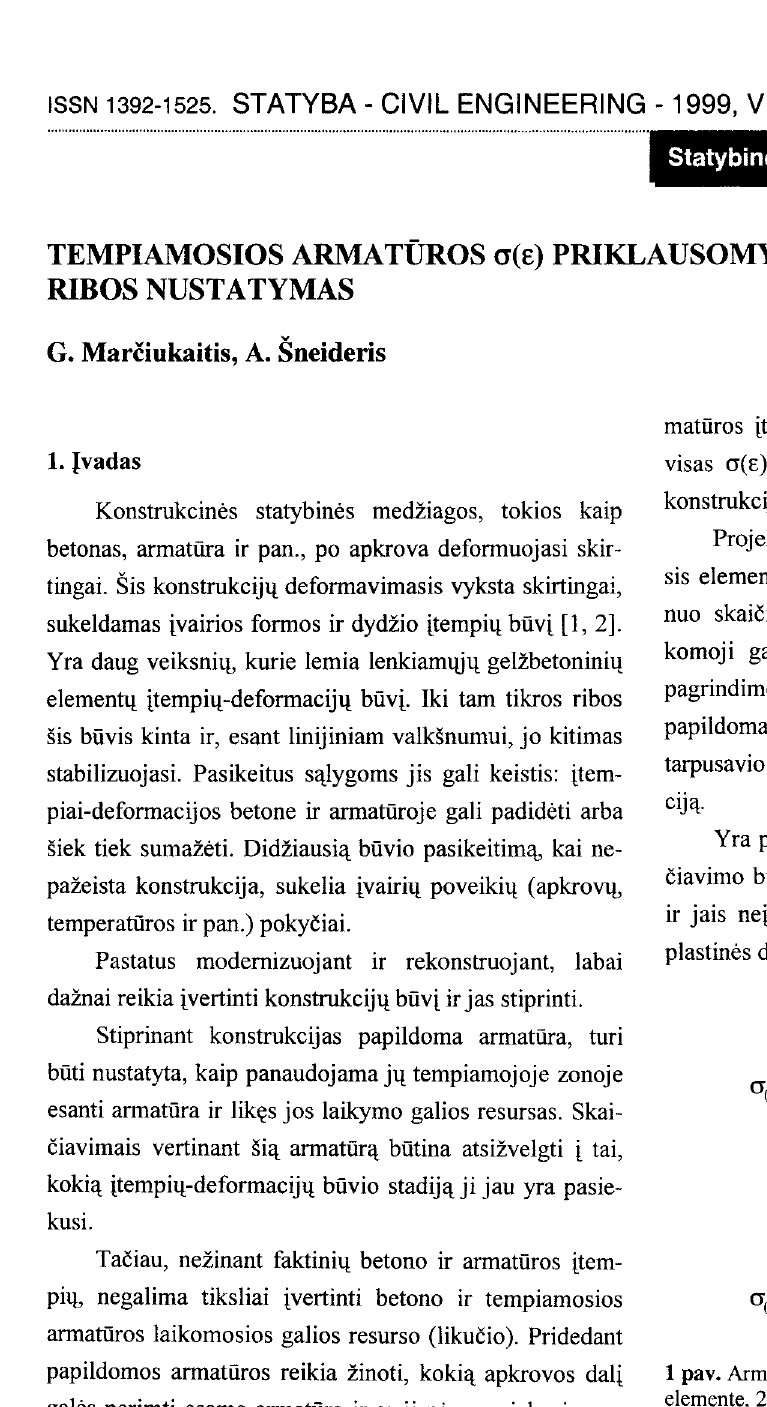
Fig 1. Stress-strain curves for the reinforcement: 1 - placed in the structure, 2 - added on structure as additional reinforcement Konstrukcijas, sustiprintas is anksto itemptomis